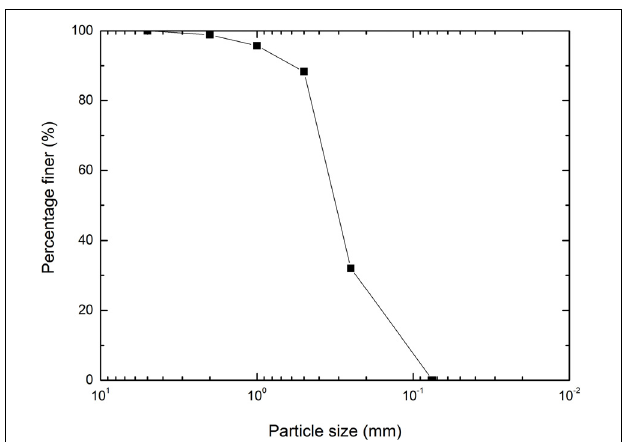
FIGURE 1 | Particle size distribution of sample.